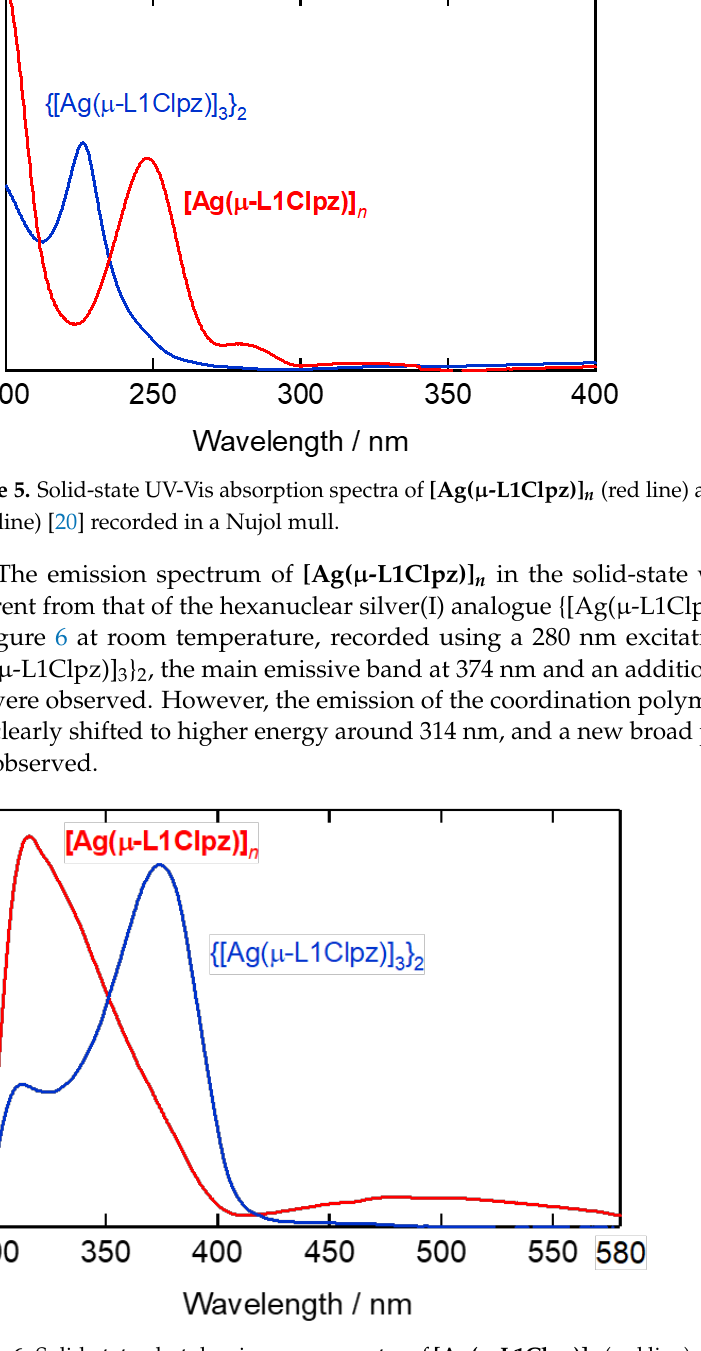
Figure 6. Solid-state photoluminescence spectra of [Ag(μ -L1Clpz)] n (red line) and {[Ag(μ -L1Clpz)] 3 } 2 (blue line) [20] at room temperature recorded at 280 nm excitation wavelength. The temperature-dependent photoluminescence spectra in [Ag(μ -L1Clpz)] n were band of [Ag(μ -L1Clpz)] n at 83 K exhibited an additional vibrational fine structure around